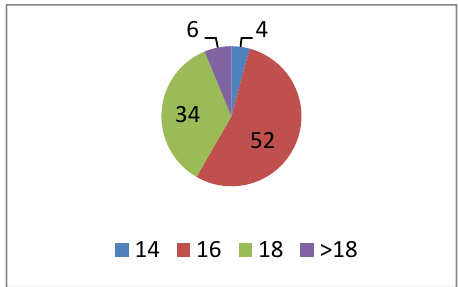
Fig. 1. Years of educational background